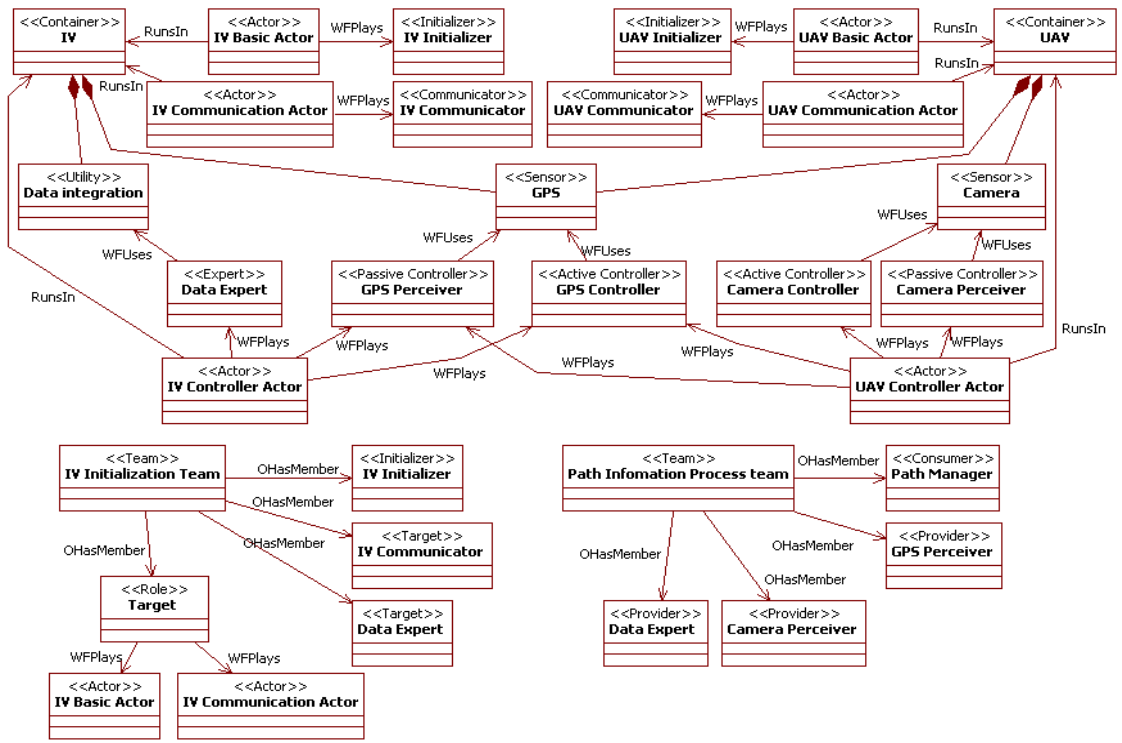
Figure 5. Partial design of the system after the first stage. It includes the containers and their elements, the initialization teams, and the information process